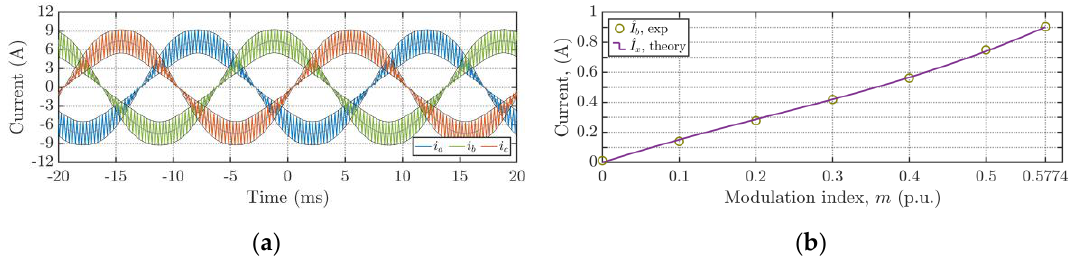
Figure 35. ( a ) Phase currents with primary (black) and secondary (gray) envelopes in case of THIPWM1/6 ( m = 1/√3); ( b ) Phase current ripple rms in case of THIPWM1/6.